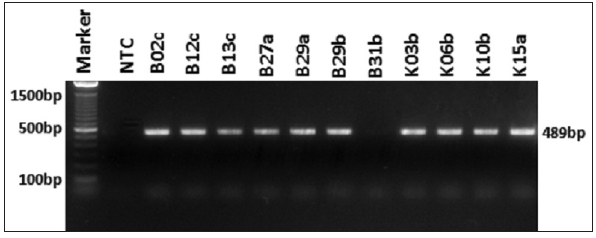
Figure-2: Amplification of bla Klebsiella pneumoniae . All isolates showed positive results of bla . NTC: Non template control. TEM